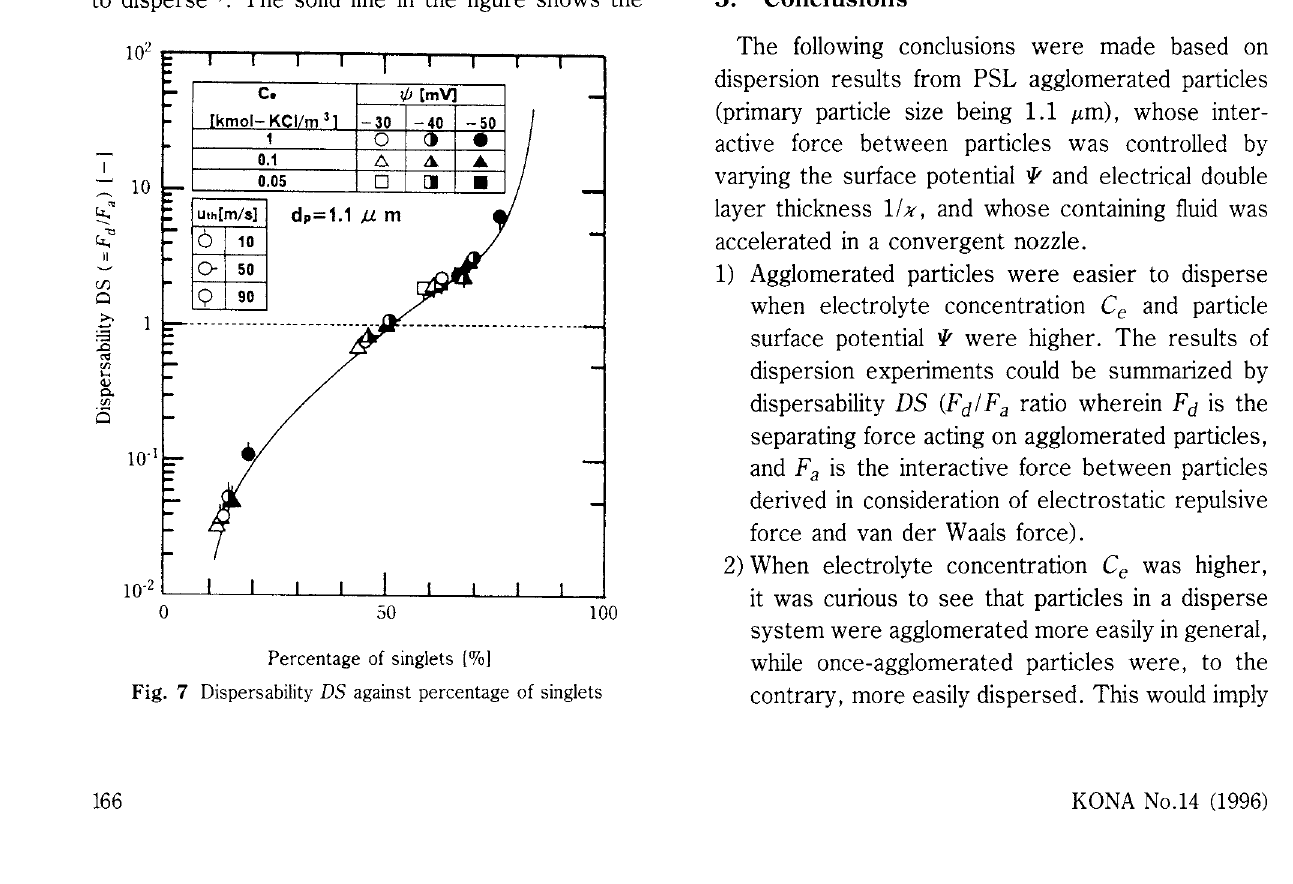
Fig. 7 Dispersability DS against percentage of